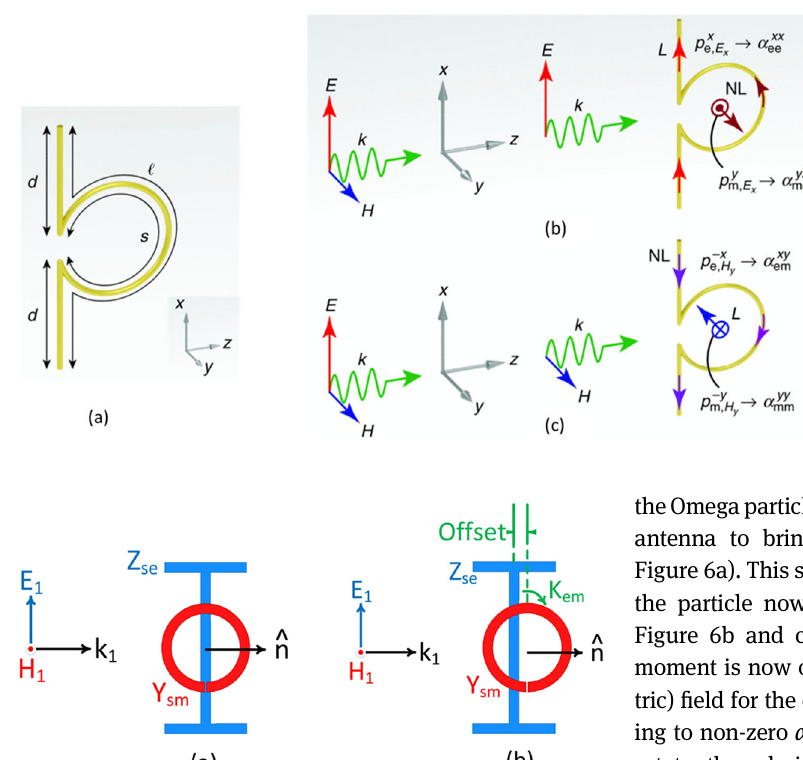
Figure 5: Wire – loop Omega bianisotropic particle. The wire is isolated from the loop by an air-gap (reprinted with permissionfrom Ref. [21]). (a) Symmetric wire – loop con fi guration only contains electric and magneticresponsesandisnotmagnetoelectric.(b)Byintroducingan offset(asymmetry), thenet magnetic fl uxthroughtheloopcreated by the wire is non-zero leading to tunable magnetoelectric